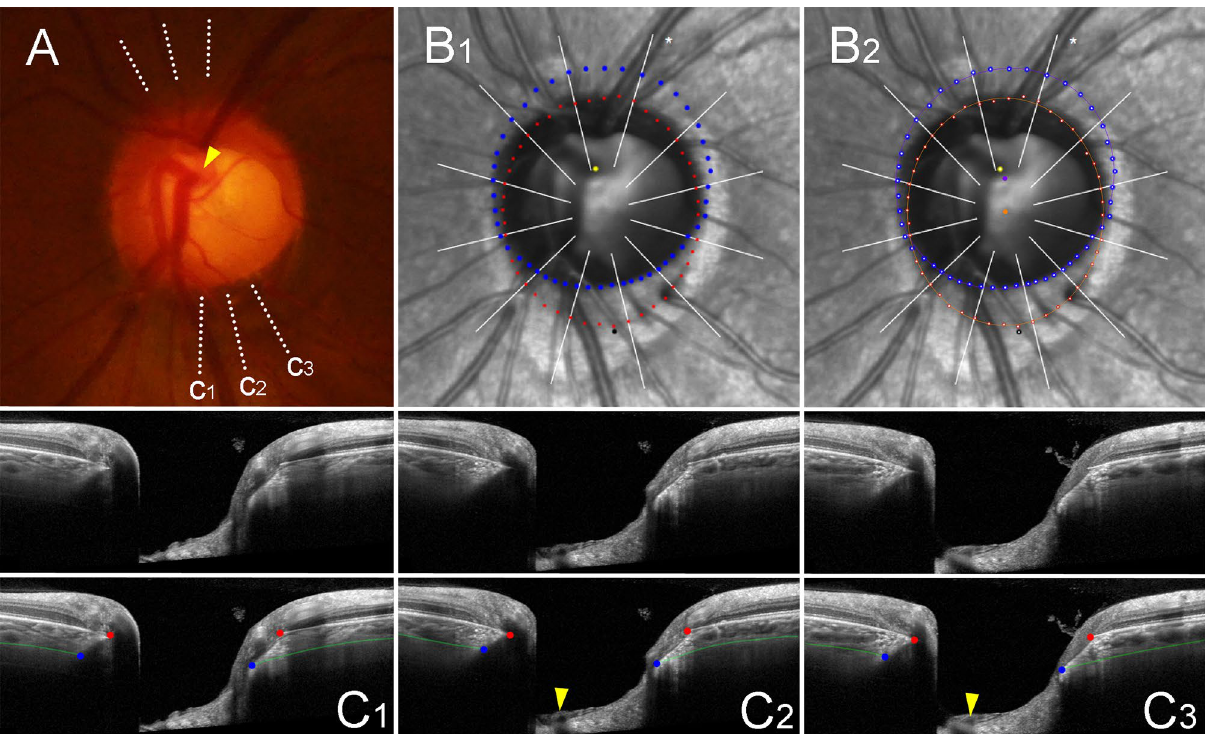
Figure 4. Sample case of outer-wall shift to superior side (left eye of 44-year-old man with glaucoma, axial length of 25.36 mm). ( A ) Disc photograph. The arrowhead indicates the location of the central retinal vascular trunk (CRVT). The dotted lines indicate the location of the OCT scan. ( B ) Infrared images. ( B 1 ) Bruch’s membrane opening (BMO, red dots), anterior scleral opening (ASCO, blue dots), CRVT position (yellow dot), and meridian of longest externally oblique border (EOB, black dot) are marked. ( B 2 ) Best-fitted ellipses for BMO (orange ellipse) and ASCO (purple ellipse) are drawn with their centers (orange dot for BMO center, purple dot for ASCO center). ( C ) B-scan OCT images (top row: original images, bottom row: images with labels). The red dots indicate the BMO margin; the blue dots indicate ASCO margin; the green lines indicate the anterior scleral surface; the arrowhead indicates the CRVT. The ASCO margin is completely demarcatable, and thus, this eye is classified into the complete demarcation group for ASCO. Please note that both the CRVT and ASCO offsets are headed superiorly, while the extent is larger for the CRVT offset than for the ASCO